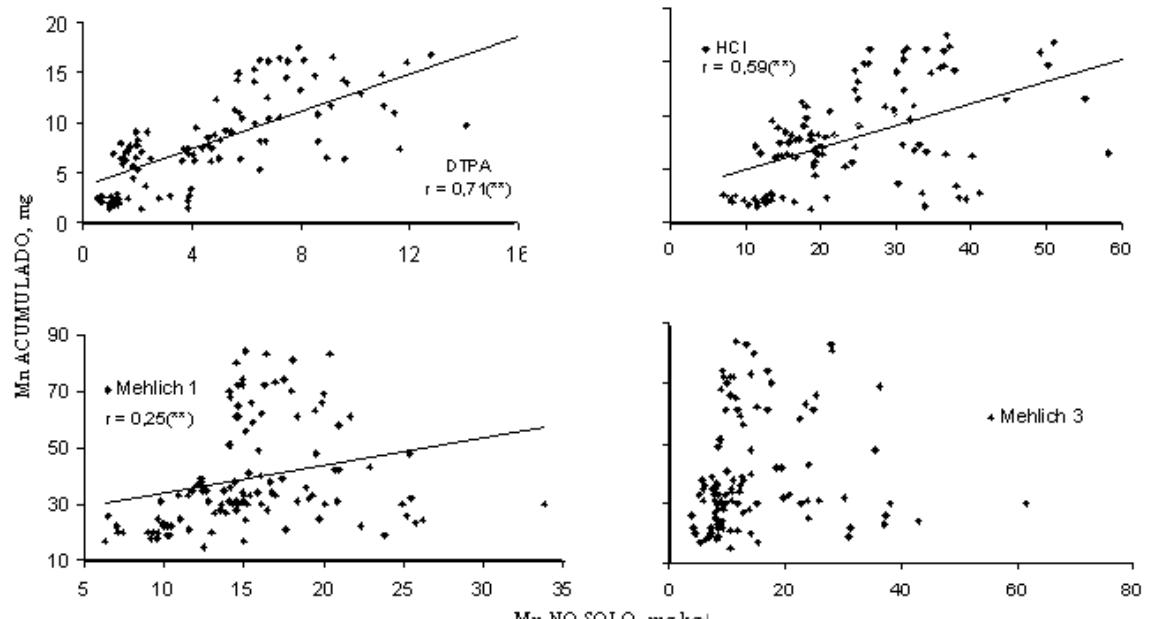
Figura 9. Correlações entre os teores de manganês do solo, extraídos por diversos extratores, após três meses da aplicação ao solo com a quantidade de manganês acumulado na parte aérea. ns = não- significativo, * e ** significativo a 1 e 5